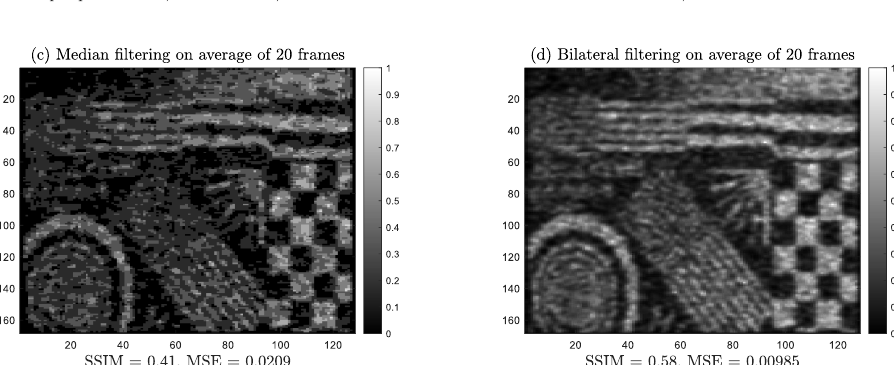
Figure 6. Image reconstruction of 20 × 0.1 µ s exposure frames from the SPAD camera, with a total of 1.41 photons per pixel. ( a ) Shows the result of averaging across these twenty frames, ( b ) the average of the retrodictions of the twenty frames, ( c ) is the result of median filter, over a 3 × 3 pixel region, being applied to ( a , d ) the results of a bilateral filter applied to ( a ). SSIM and MSE results are shown for each of the figures.